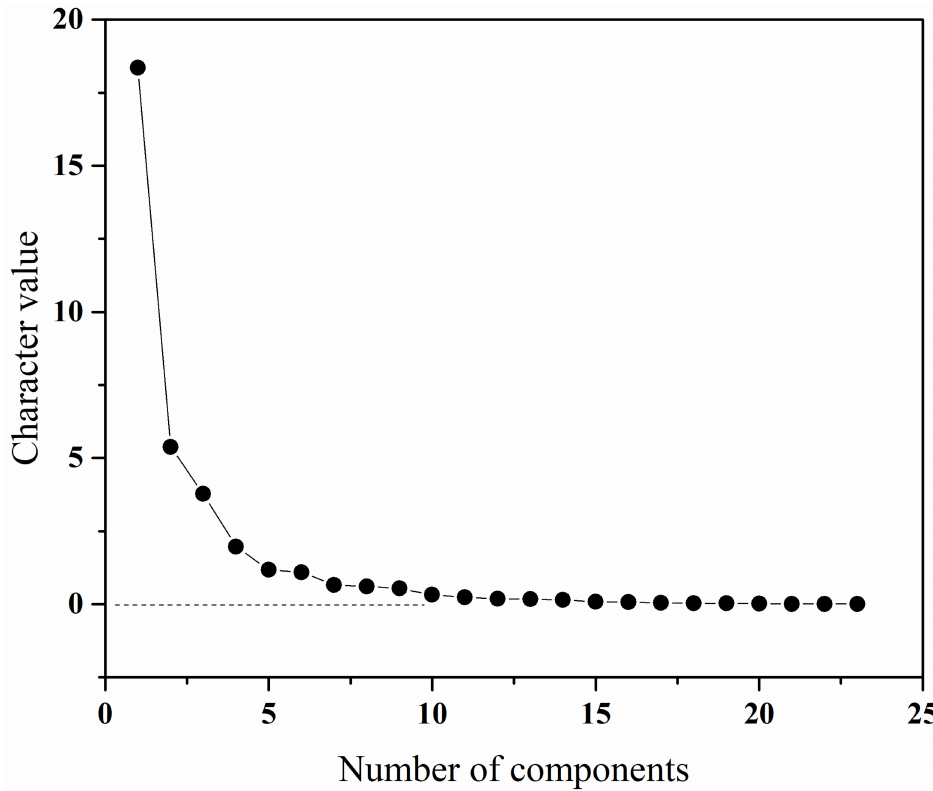
Figure 4. Gravel plot of the explanatory rate of the characteristic